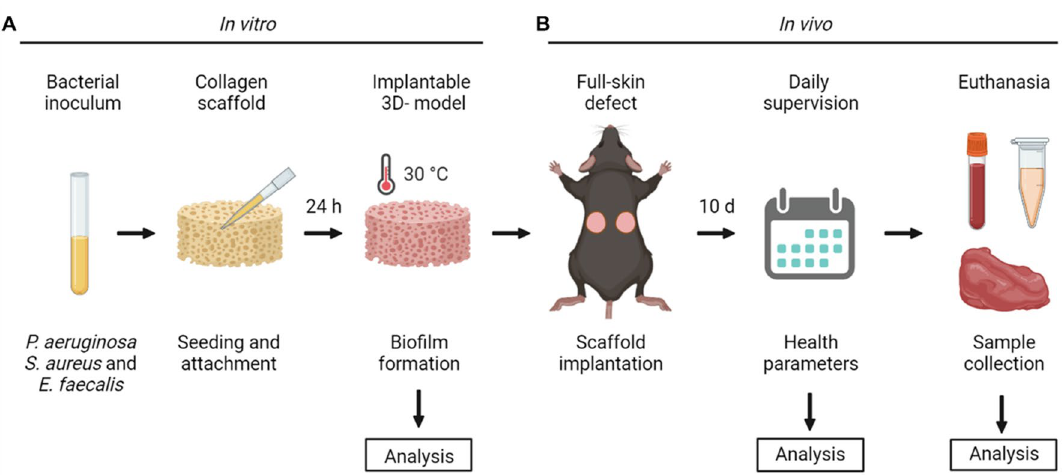
Figure 1. Schematic representation of the in vitro and in vivo biofilm model. ( A ) Strains from P. aeruginosa , S. aureus and E. faecalis were diluted and seeded on collagen scaffolds to induce biofilm formation. After 24 h of incubation, the biofilm in vitro model was analyzed in means of metabolic activity, bacterial loads, structure and antibiotic tolerance. ( B ) Once characterized, biofilm-containing scaffolds were implanted in bilateral full-skin defects in mice during 10 days to evaluate the effect over general health parameters through daily supervision. Further analysis of the animal samples were performed, including histology and immunohistochemistry, bacterial loads, pro-calcitonin and cytokine levels. Image was made with BioRender.